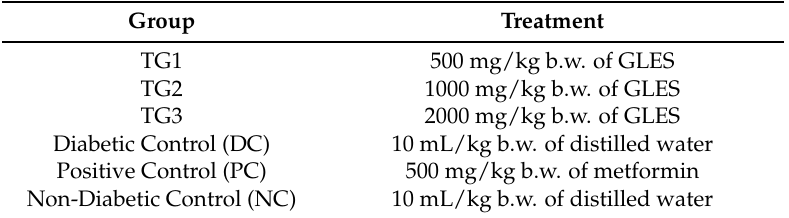
Table 1. Animal Grouping: Acute treatment with Gongronema latifolium extract.